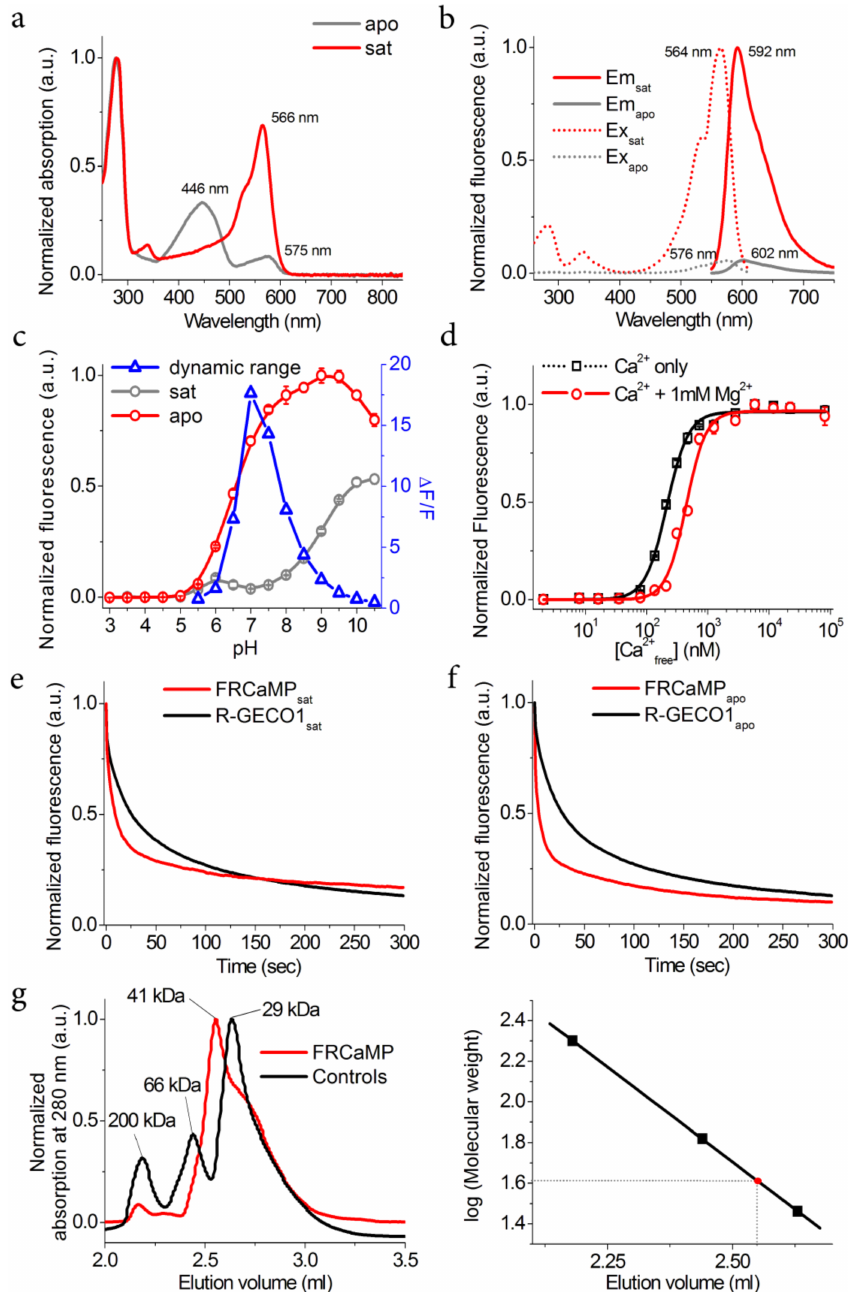
Figure 2. In vitro properties of the purified FRCaMP indicator. ( a ) Absorption spectra for FRCaMP in the Ca 2+ -bound (sat) and Ca 2+ -free (apo) states at pH 7.20. ( b ) Excitation and emission spectra